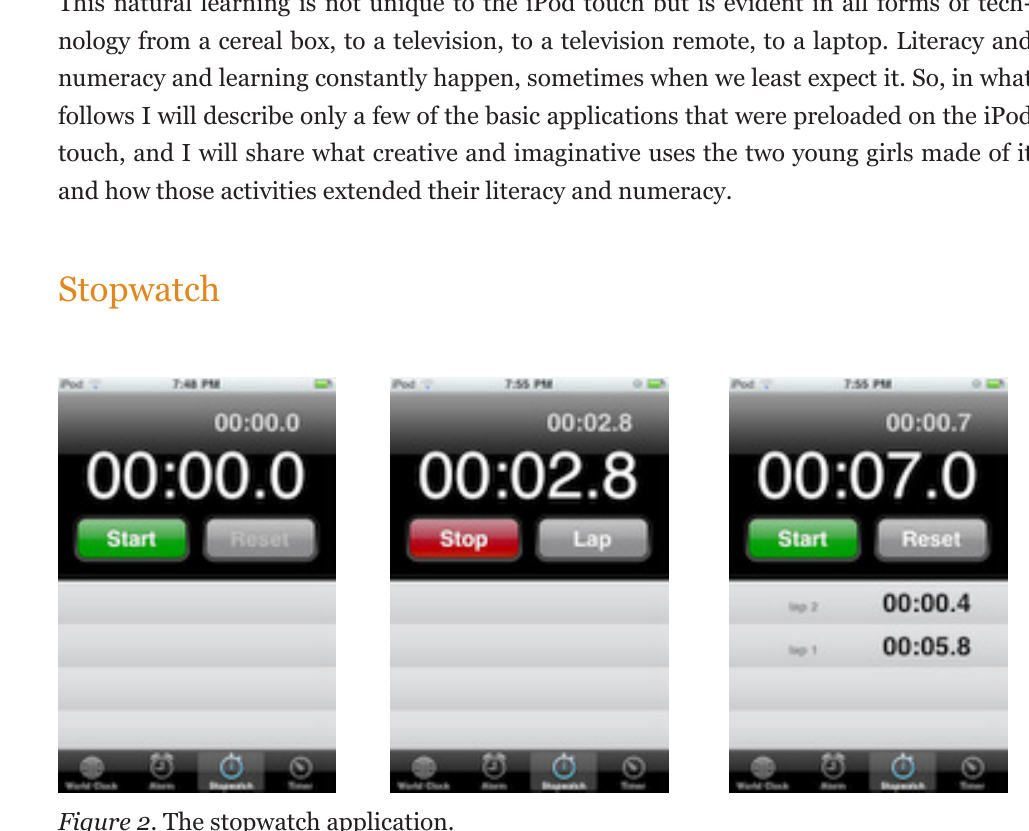
Figure 2 . The stopwatch